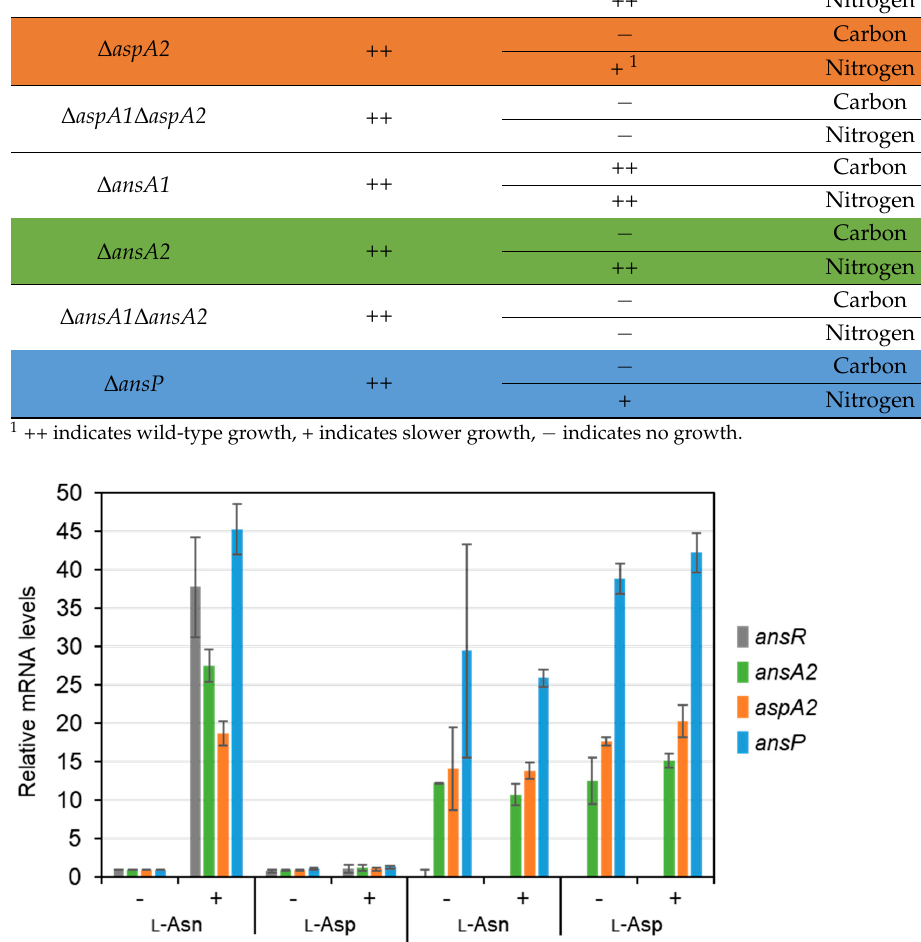
Figure 3. The promoter region of the ans operon. The transcriptional start site is indicated with +1. The initiation codon of ansR is shown in bold letters. The incorrect initiation codon previously deposited is indicated with an underline. The − 35 and − 10 regions of the σ A -dependent promoter are indicated using boxes. 3.4. ans Operon Repressed by AnsR The first gene of the operon, ansR, encoded a GntR-type transcriptional regulator. To examine whether the regulator was involved in the L-Asn-responsive expression of the operon, an ansR gene deletion mutant was constructed. The wild type and ansR deletion mutant were cultivated in nutrient-rich medium and supplemented with L-Asn or L-Asp to examine the changes in the expression of the ans operon, as described above. The expression of the operon genes in the deletion mutant was much higher than that in the wild type before the supplementation of amino acids (Figure 2). The expression levels of the genes in the mutant were maintained for 30 min with L-Asn or L-Asp supplementation. In the wild type, the expression of the ans operon was not altered upon supplementation of L-Asp. These findings indicate that the ans operon was repressed by AnsR. The growth of the ansR deletion mutant on nutrient-rich medium supplemented with L-Asp was comparable to that of the wild type, whereas the mutant reached a slightly higher OD than the wild type in the growth experiments carried out using medium supplemented with L-Asn. 3.5. AnsR Directly Repressed the ans Operon To examine whether AnsR directly represses the ans operon, the binding of AnsR to the promoter region of the operon was investigated using EMSA. A DNA probe encompassing the promoter region (positions − 209 and +21 with respect to the TSS) was